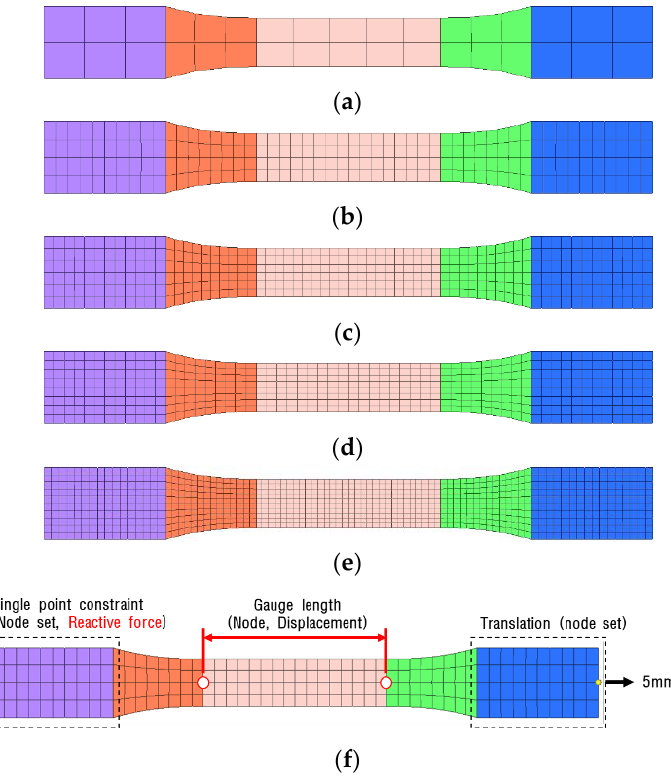
Figure 4. Finite element models for tensile test specimens: ( a ) element division 2 (average element size: 8.125 mm); ( b ) element division 4 (average element size: 4.0625 mm); ( c ) element division 6 (average element size: 2.7083 mm); ( d ) element division 8 (average element size: 2.0313 mm); ( e ) element division 10 (average element size: 1.625 mm); ( f ) finite element analysis model for tensile specimen.